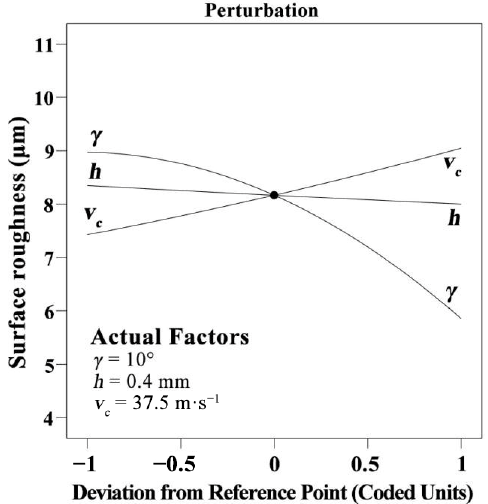
Figure 8. Effect of cutting conditions on surface roughness.